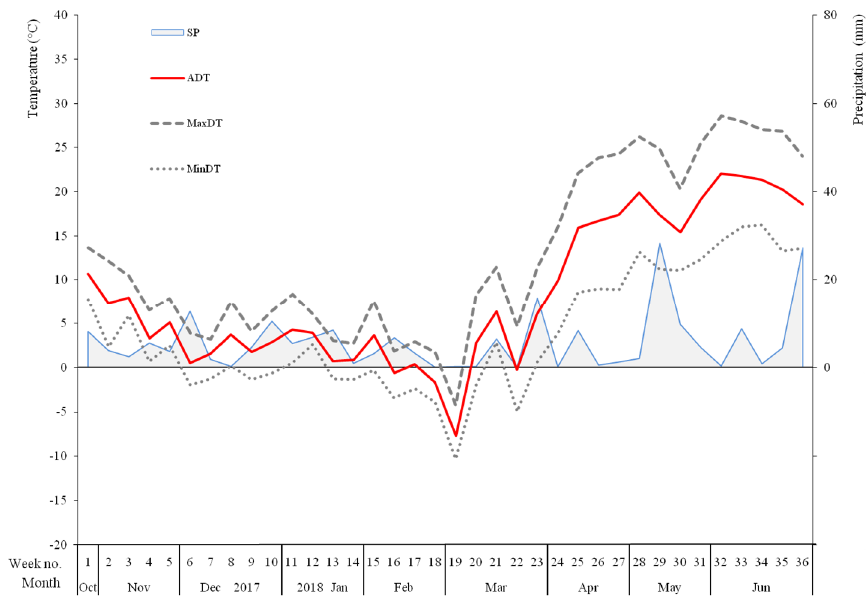
Figure 1. The characteristics of weather conditions during the experiment period in Lednice location.